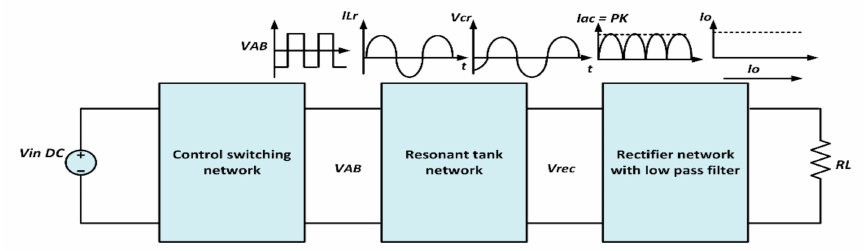
Figure 17. Structure of resonant converters